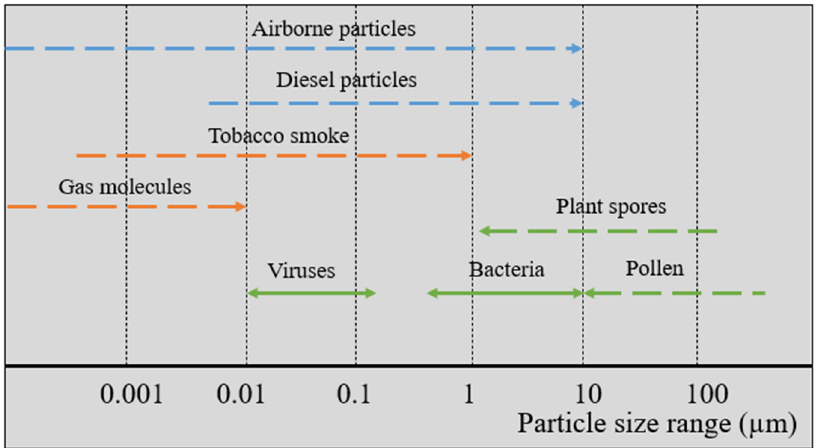
Figure 6. Size ranges of main particles in indoor air.